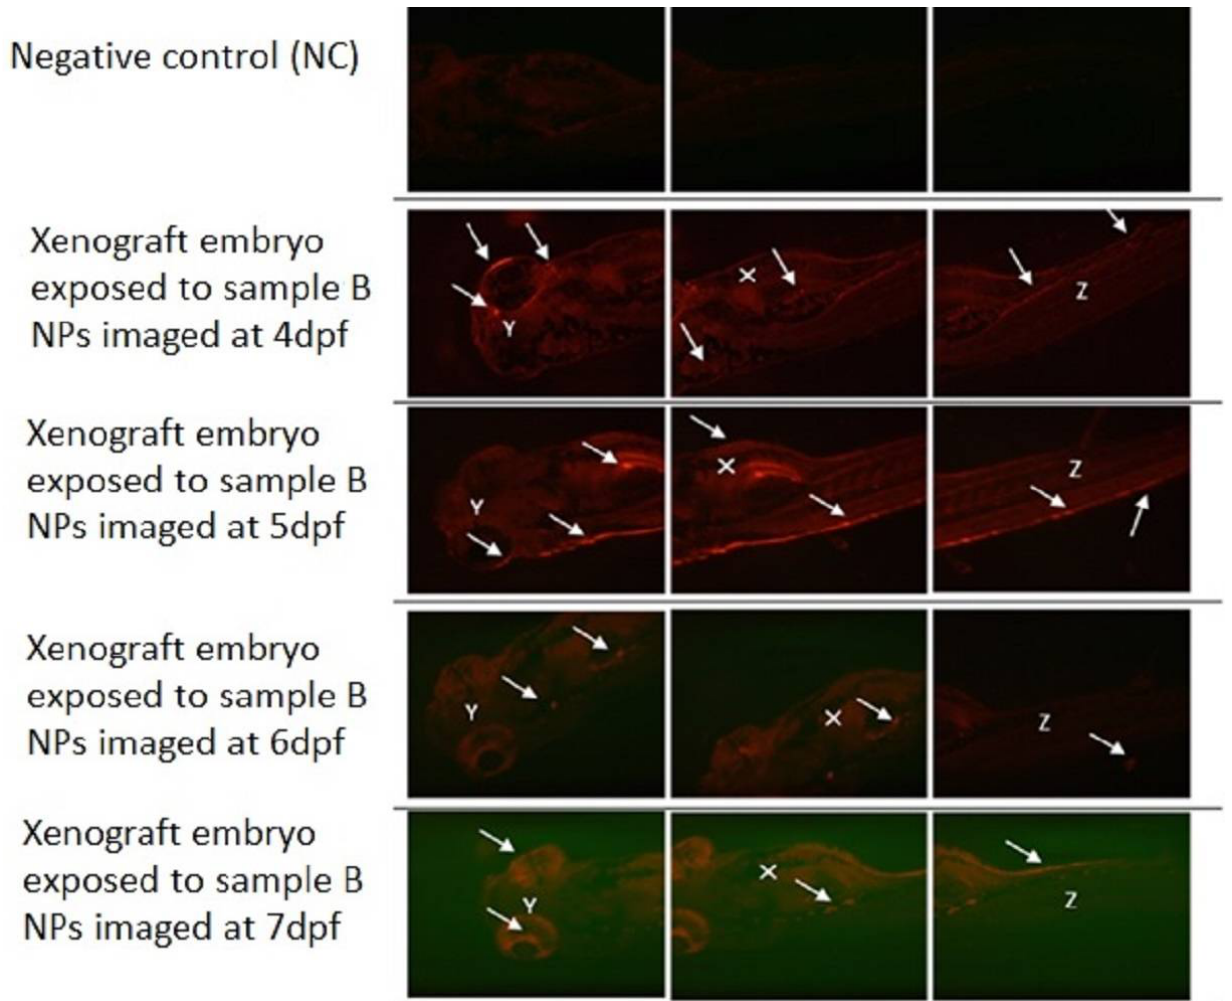
Figure 9. Xenograft model exposed sample B PLGA-PEG-PLGA NPs with 10 mg Ponatinib. Repre- sentative fluorescence images of zebrafish screening at 4 dpf until 7 dpf using fluorescent microscopy and investigation of fluorescent K562 cells proliferation (White solid arrows) throughout the animal body (Y—eyes; X—yolk sac; Z—tail) using mCherry fluorescence filter after exposing zebrafish embryos to of sample B PLGA-PEG-PLGA NPs (0.001 mg/mL). Original magnification 100×.